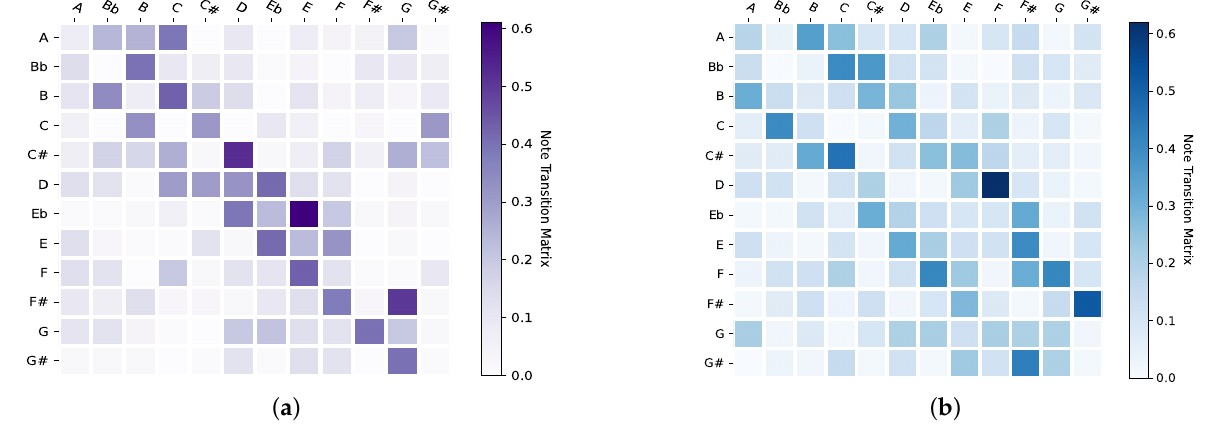
Figure 15. Note transition matrix of 3D-SCN ( a ) and BoYaTCN ( b ). The vertical axis indicates the previous note and the horizontal axis indicates the note that follows. The musical melodies generated by the 3D-SCN and BoYaTCN music generation models were also relatively smooth and stable with even energy distribution. The intervals span across three and a half octaves and range from one-lined octave to three-lined octave, as shown in Figure 16.